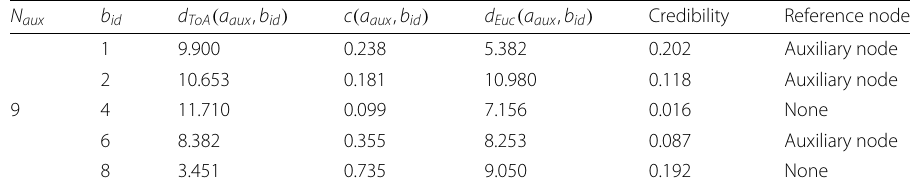
Table 2 Auxiliary node screening